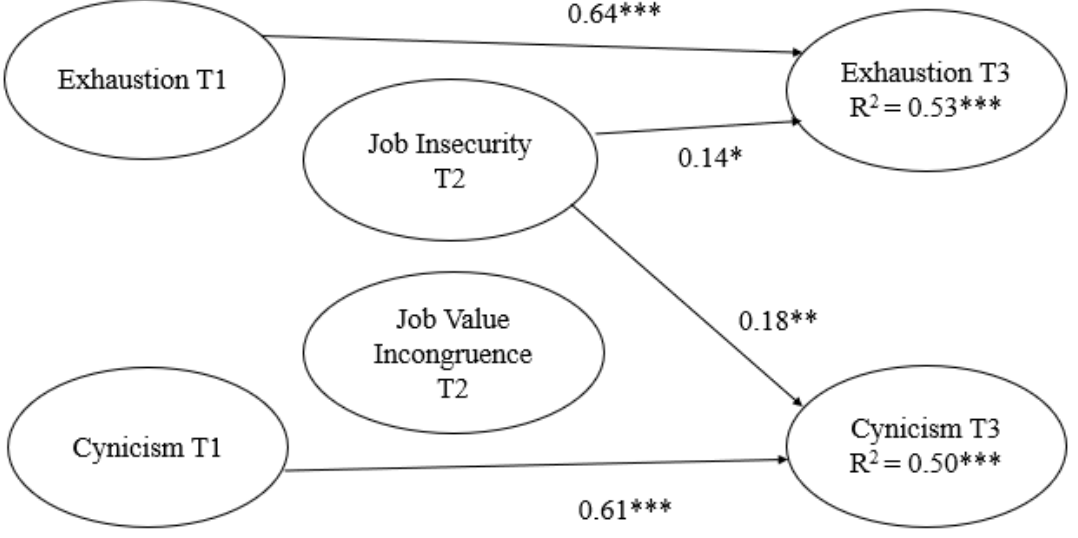
Figure 2. Job insecurity and job value incongruence predicting psychological ill-being. N = 299. Model fit: χ 2 (233) = 480.75, p = 0.000, CFI = 0.91, TLI = 0.90, RMSEA = 0.06 (90% CI 0.05–0.07), SRMR = 0.06. * p < 0.05, ** p < 0.01, *** p < 0.001.